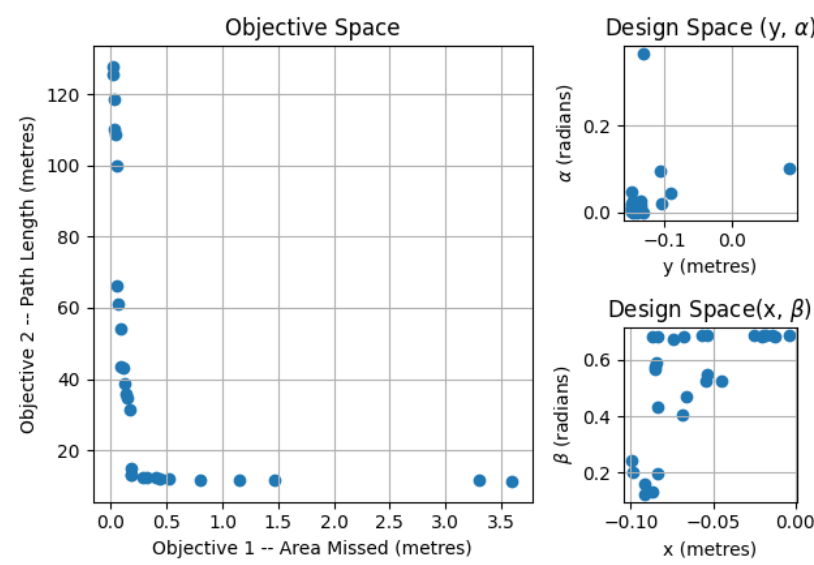
Figure 9. NSGA2 optimization for area size 4 × 2 m with population size = 2000.